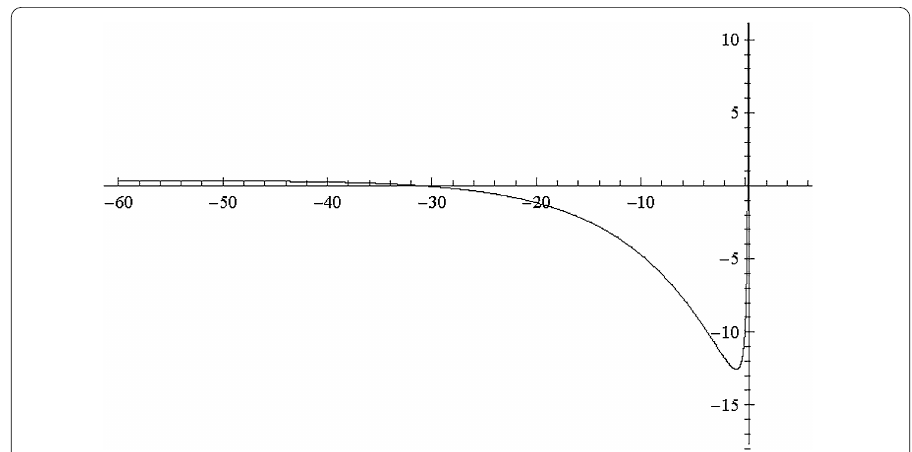
Figure 9 Graph of (cid:2) d ( ς ) for Example 3 around ς 2